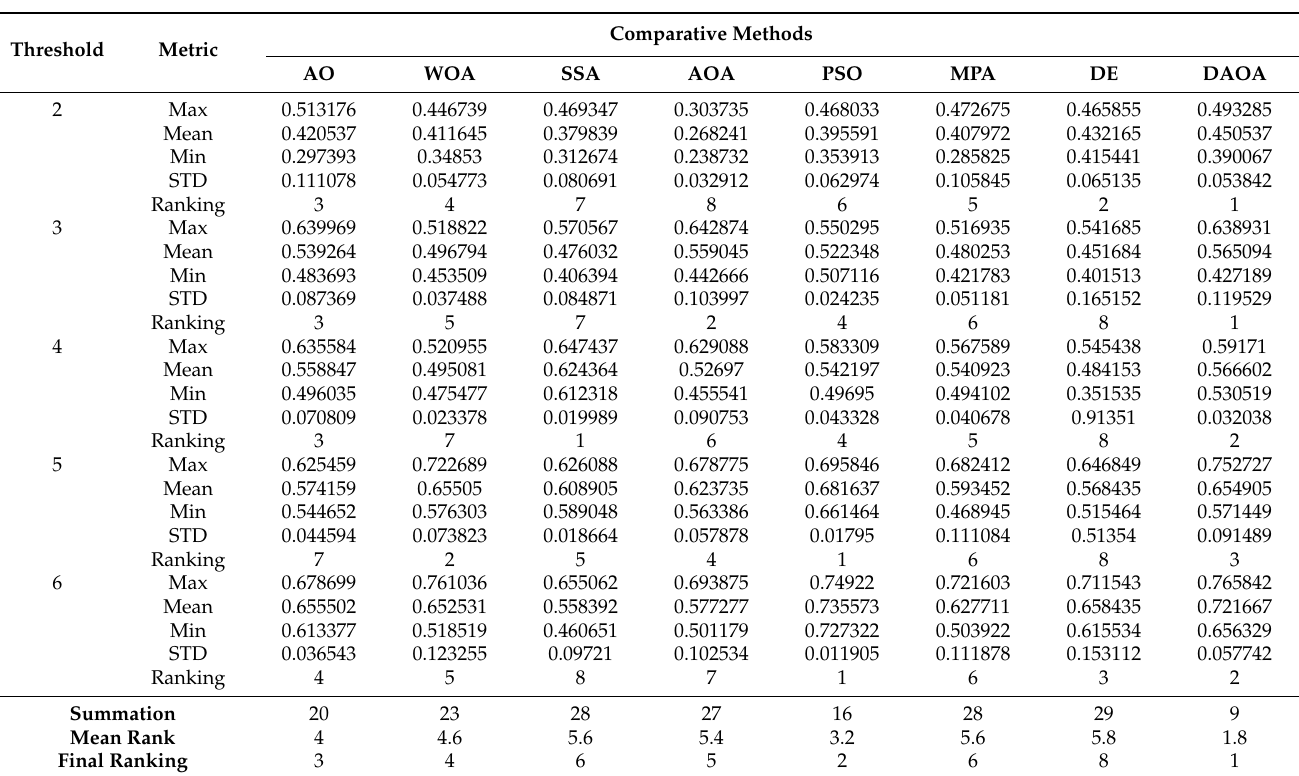
Table 9. The SSIM results of the test case